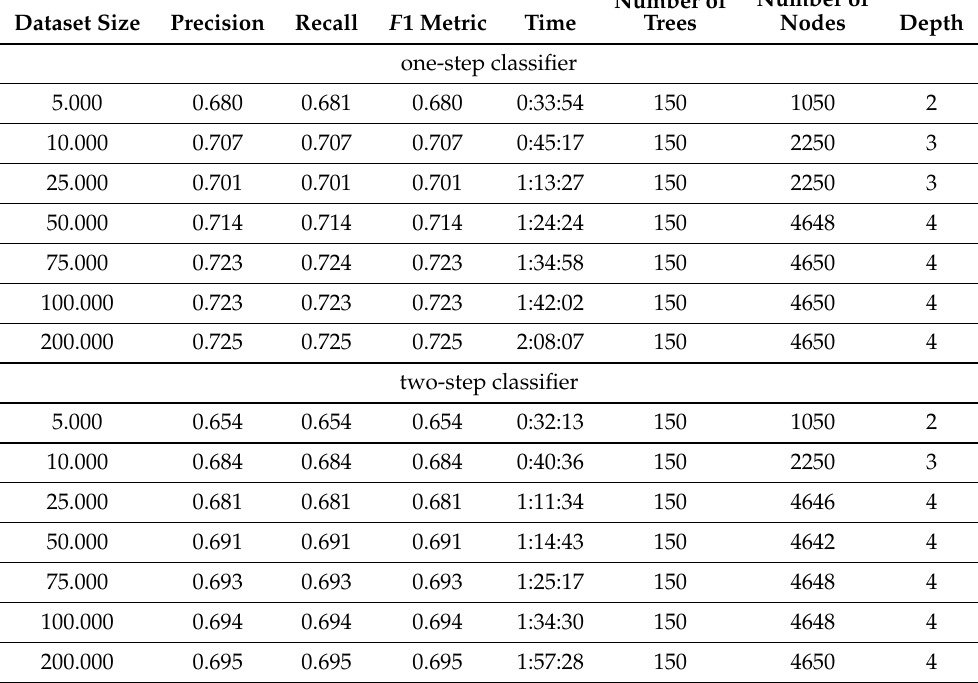
Table 4. Gradient-boosted trees.